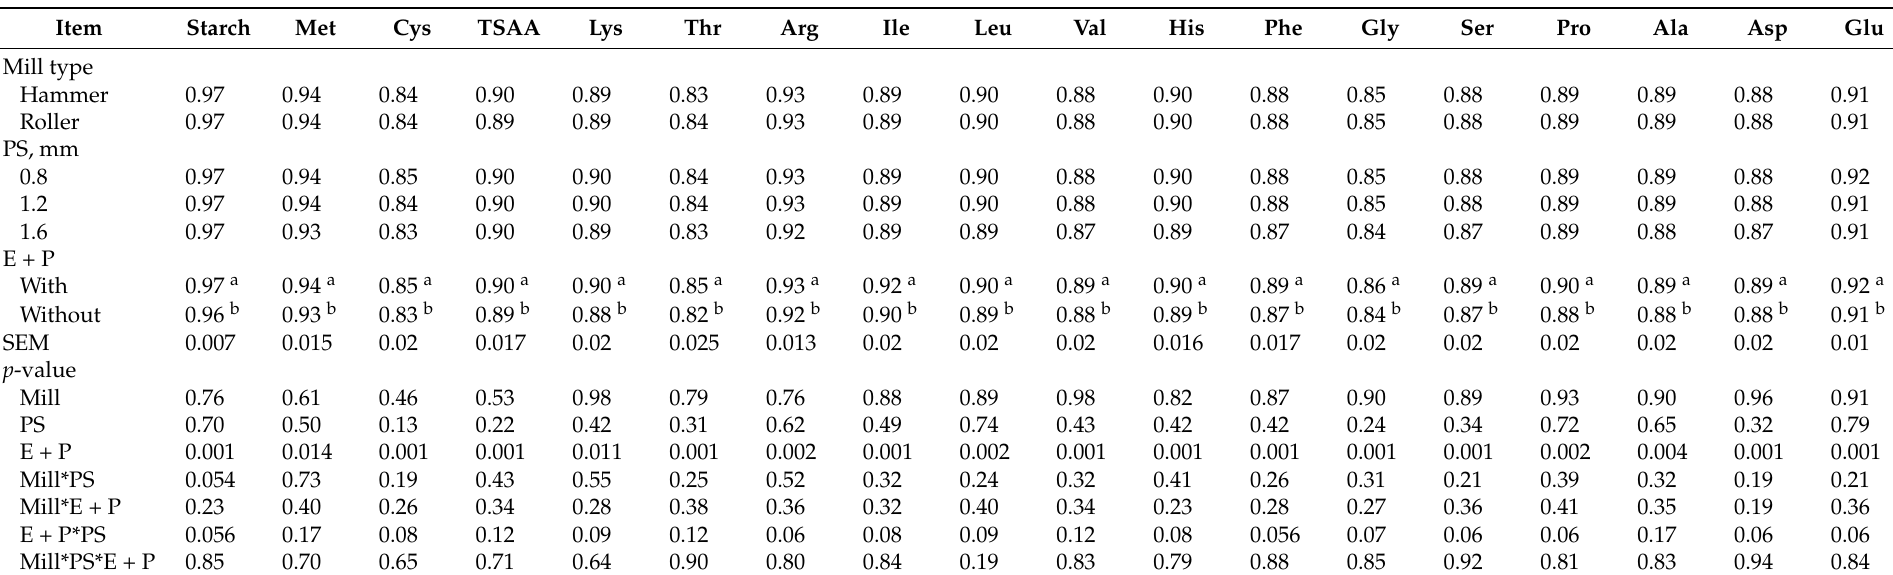
Table 9. Results for 38-day-old broilers showing apparent ileal nutrient digestibility coefficients (DM) of finisher diets processed according to treatments with